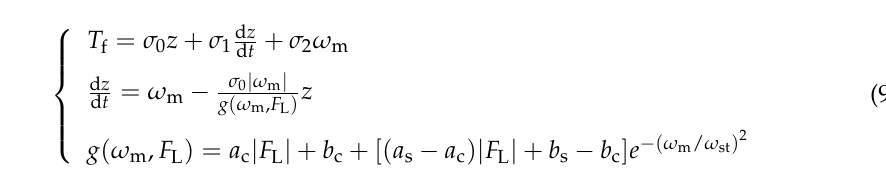
Table 1. Parameter identification results of the improved friction model.